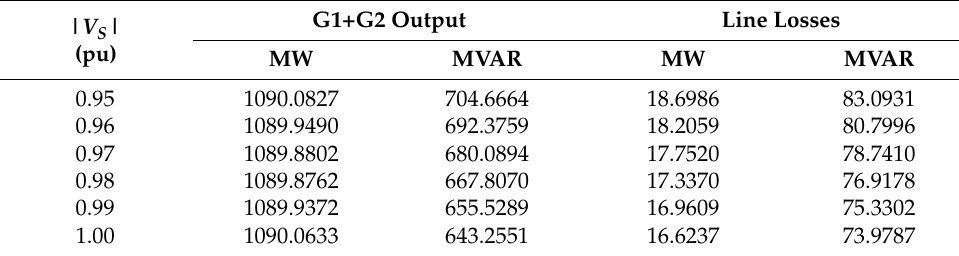
Table 15. G1+G2 output and line loss ( V w = 10